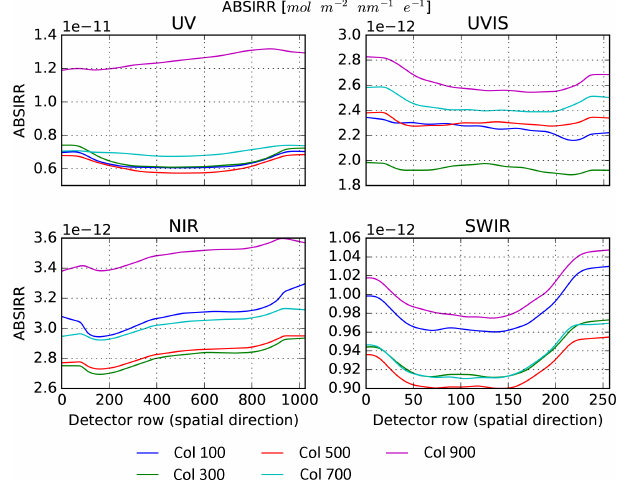
Figure 17. The absolute irradiance CKD for QVD1 is shown for each detector in columns 100 (blue line), 300 (green), 500 (red), 700 (turquoise), and 900 (magenta) for each